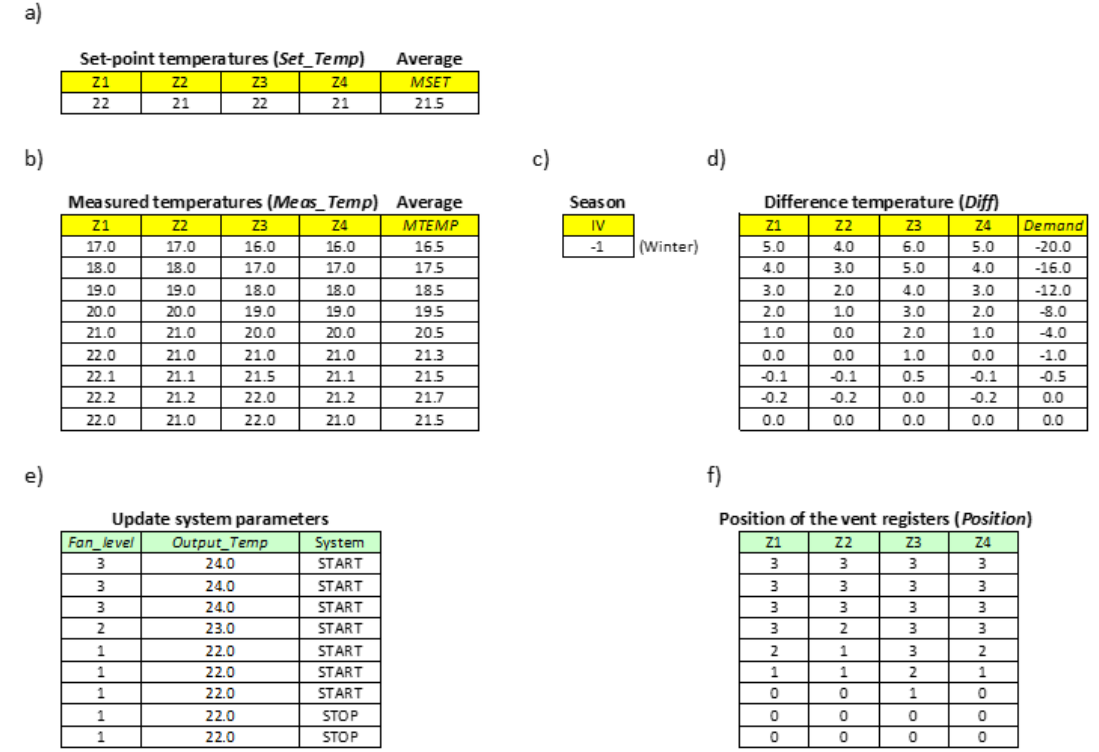
Figure 13. Example of simulation of the algorithm in the winter season. ( a ) Set-point temperatures, ( b ) measured temperatures, ( c ) season, ( d ) di ff erence temperatures, ( e ) updating system parameters, ( f ) position of the vent